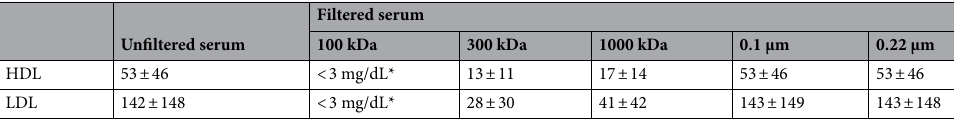
Table 3. HDL and LDL values in serum and serum filtered through membranes with different pore sizes. Mean ± standard deviation of three independent experiments with serum from different donors (N = 3) are shown. The values marked with * indicate measured values below the detection limit of the test